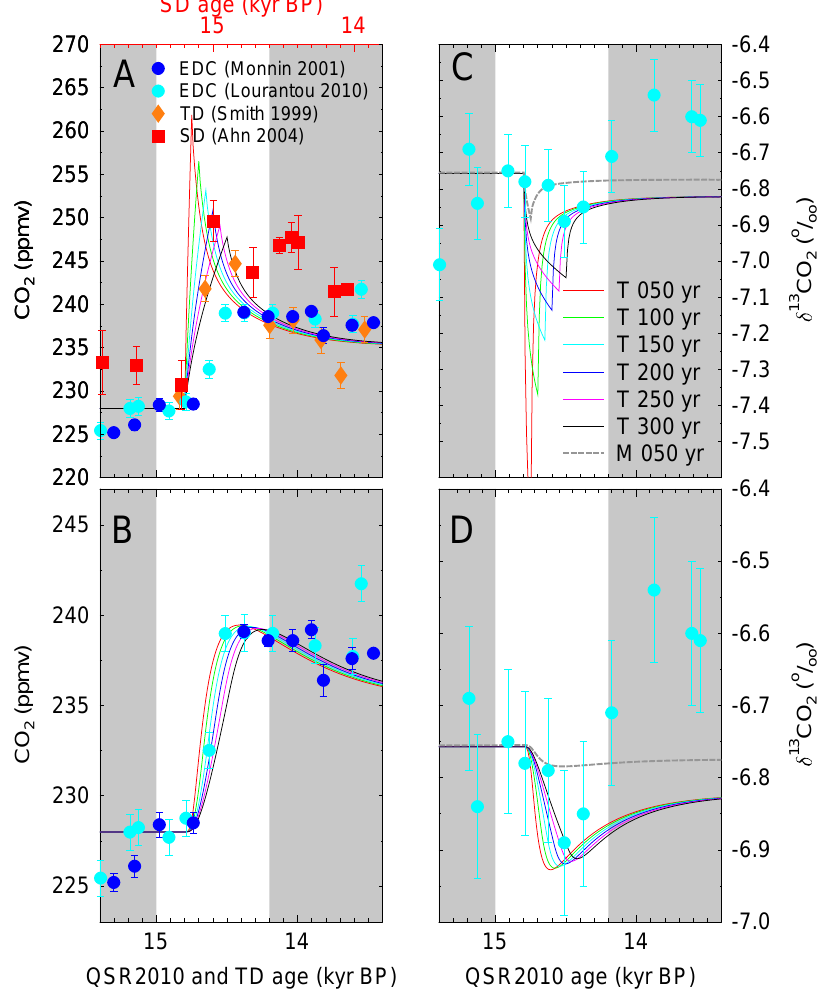
Fig. 4. Simulations with the carbon cycle box model BICYCLE for an injection of 125PgC into the atmosphere. Injected carbon was either of terrestrial ( T : δ 13 C= − 22 . 5‰) or marine ( M : δ 13 C= − 8 . 5‰) origin. Release of terrestrial C occurred between 50 and 300yr. Marine C was released in 50yr (grey), but is identical to the terrestrial release in A, B. (A) Atmospheric CO 2 from simulations and from EDC (Monnin et al., 2001; Lourantou et al., 2010) on the new age scale QSR2010 (Lemieux-Dudon et al., 2010), Siple Dome (Ahn et al., 2004) (SD, on its own age scale on top x-axis) and Taylor Dome (Smith et al., 1999) (TD, on revised age scale as in Ahn et al., 2004). All CO 2 data has been synchronised to the CO 2 jump. (B) Simulated CO 2 values potentially be recorded in EDC and EDC data. The simulated values are derived by the application of the gas age distribution PDF of the hypothetical atmospheric CO 2 values plotted in (A), followed by a shift in the age scale by the width E B / A = 400yr towards younger ages. (C, D) The same simulations for atmospheric δ 13 CO 2 , cyan dots are new EDC δ 13 CO 2 data (Lourantou et al., 2010). Only the dynamics between 15.0 and 14.2 kyr BP (white band) are of interest here and should be compared to the ice core